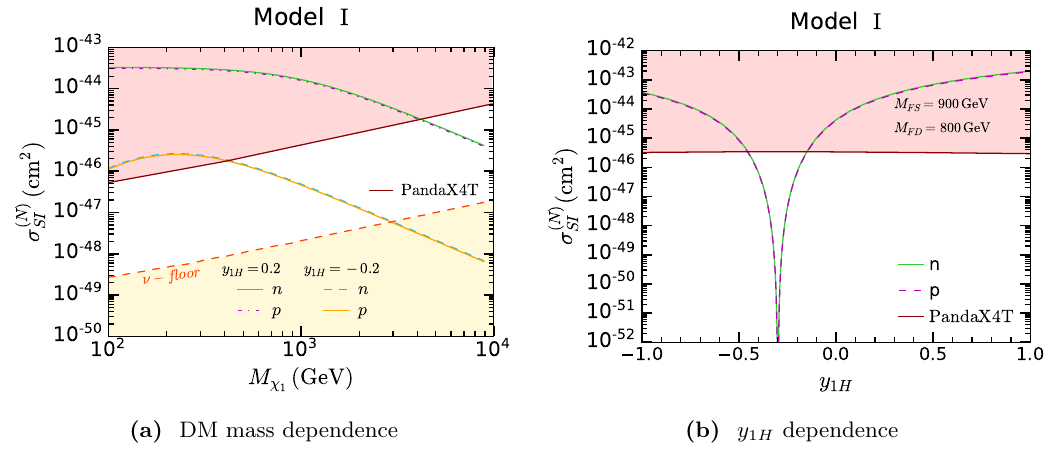
Figure 7. The DM-nucleon SI scattering cross sections as functions of (a) the DM mass M χ (b) y 1 H . The rest of the parameters are fixed as in figure 6. The red shaded area is excluded by the PandaX4T experiment [171] and the yellow shaded region corresponds to the neutrino floor [172].